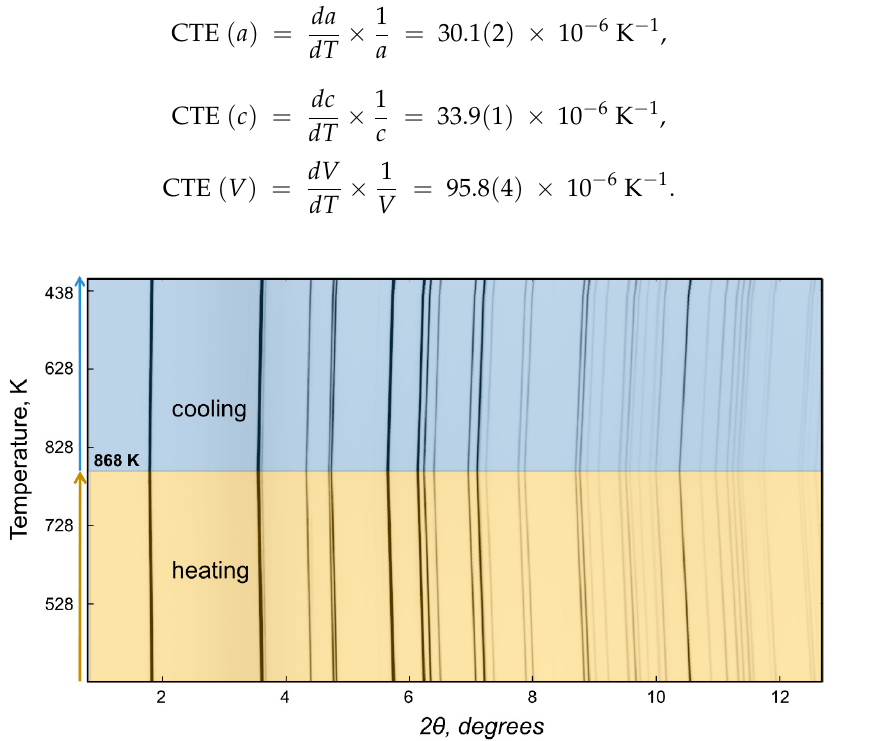
Figure 2. High-temperature synchrotron powder X-ray diffraction patterns for the NaZnSb powdered sample sealed in a silica capillary under vacuum. The “waterfall” diagram shows the evolution of XRD patterns with the concomitant change upon heating from room temperature to 868 K followed up by cooling back to room temperature. The intensity of the diffraction peaks is represented by the color intensity. Heating/cooling regions are highlighted in yellow/blue. All of the diffraction peaks can be ascribed to